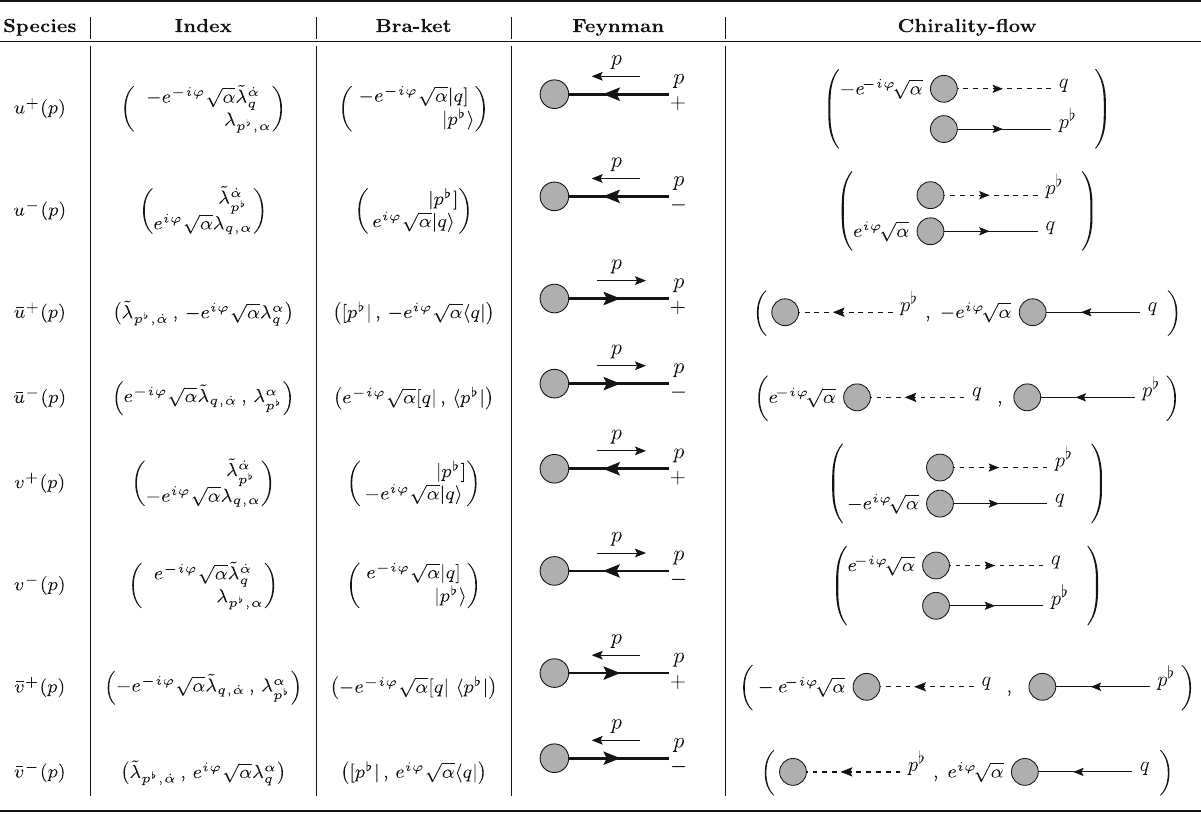
Table 1 “Rosetta stone” showing massive fixed-spin-axis fermions in several common notations. To translate the Dirac spinors to the